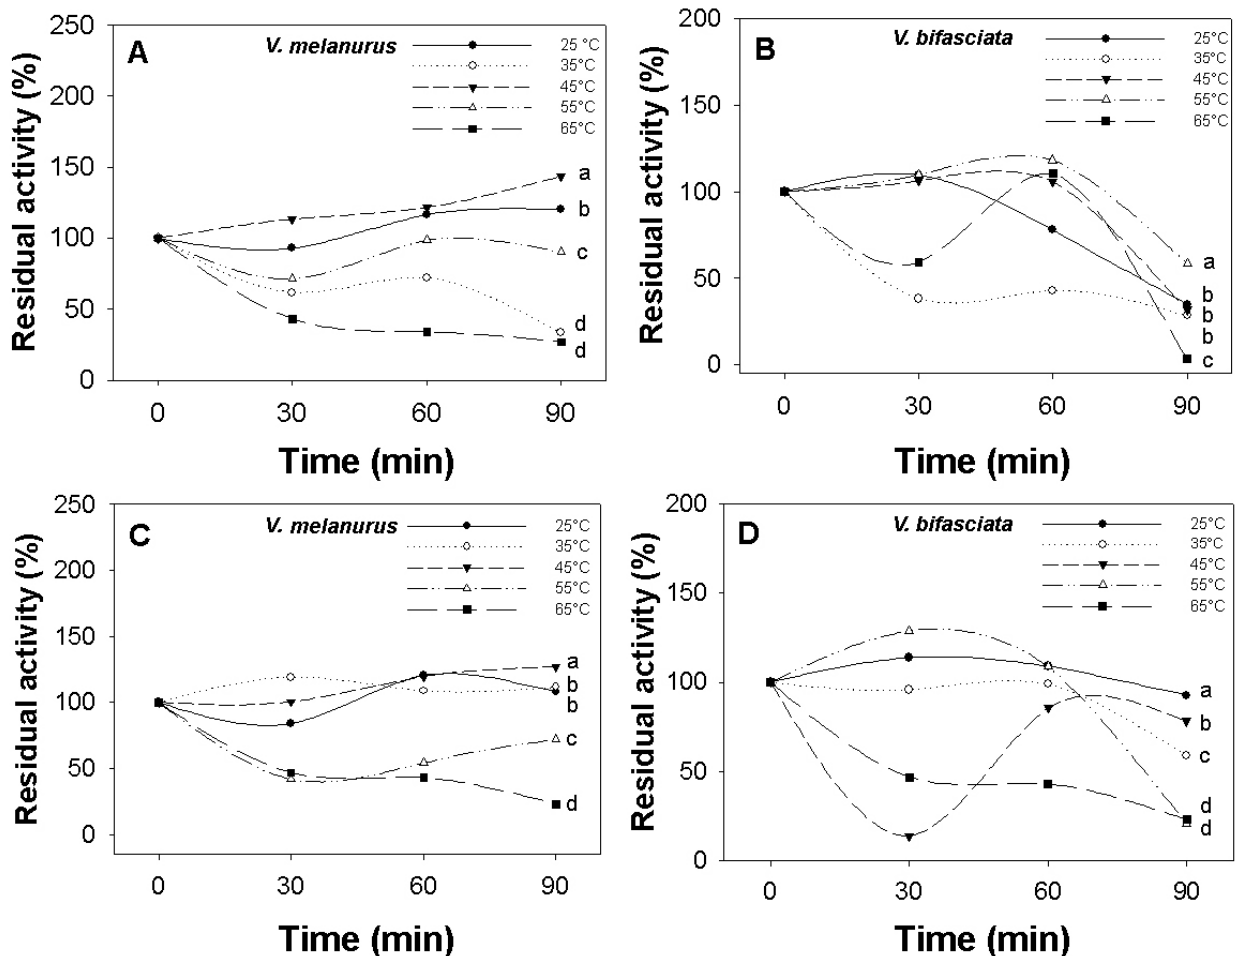
FIGURE 4 | Temperature stability of acid digestive protease for A . Vieja melanurus and B . V. bifasciata ; and alkaline digestive protease for C . V. melanurus and D . V. bifasciata (mean ± SD, n = 3). Significant differences (P< 0.05) between pH values residual activity are shown by